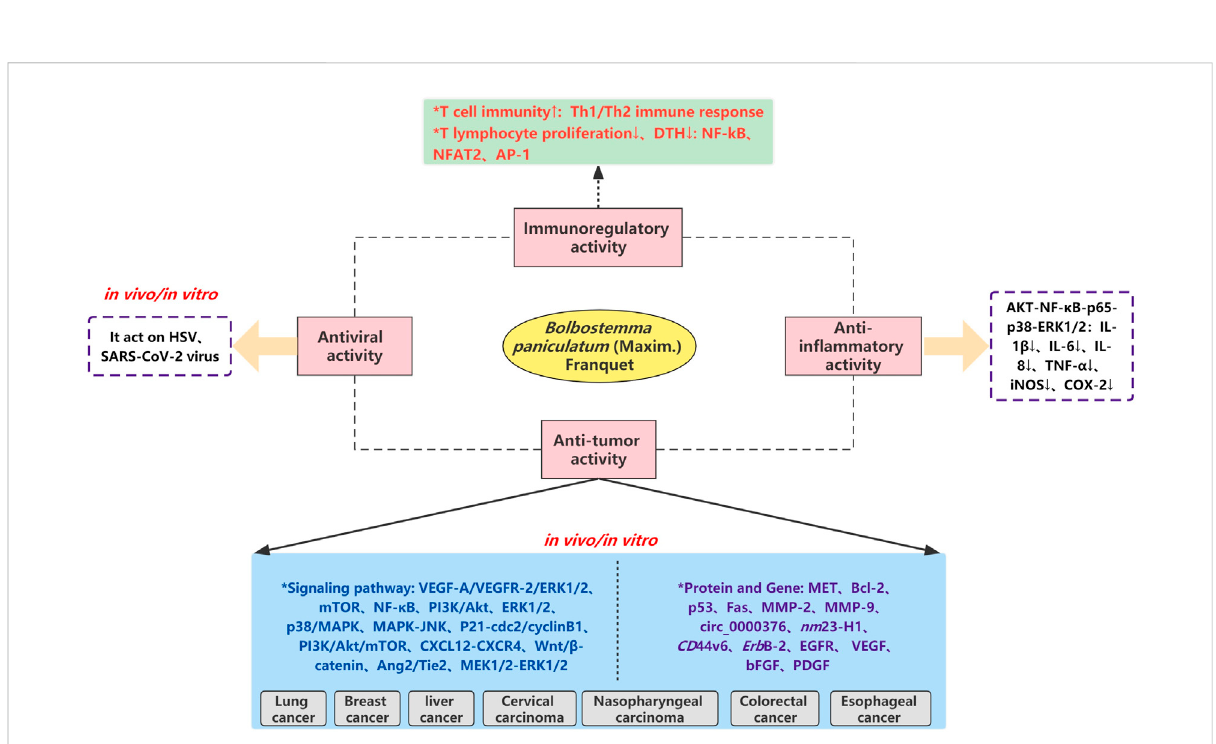
FIGURE 9 The molecular mechanism and pharmacological relationship network of Bolbostemma paniculatum (Maxim.) Franquet.